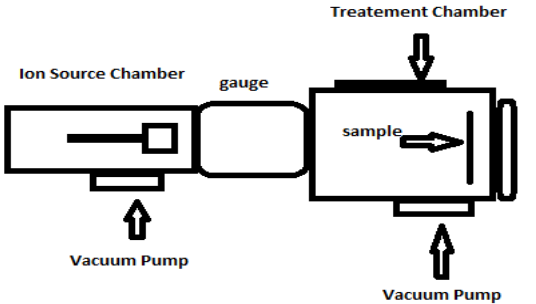
Figure 1. A schematic diagram of the experimental system employed for argon ion